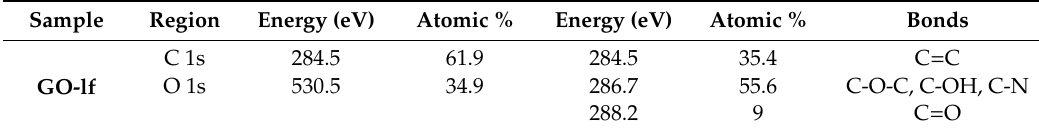
Table 1. The results of the XPS analysis for the GO-lf, rGO-lr, and rGO-hr samples. The total atomic percentage of oxygen as well as the atomic percentage of oxygen in the individual oxygen-containing functional groups from the C1s region are presented. Legend: GO-lf: graphene oxide with large flakes (10–20 µm), rGO-lr: reduced graphene oxide with low reduction level, and rGO-hr: reduced graphene oxide with high reduction level.